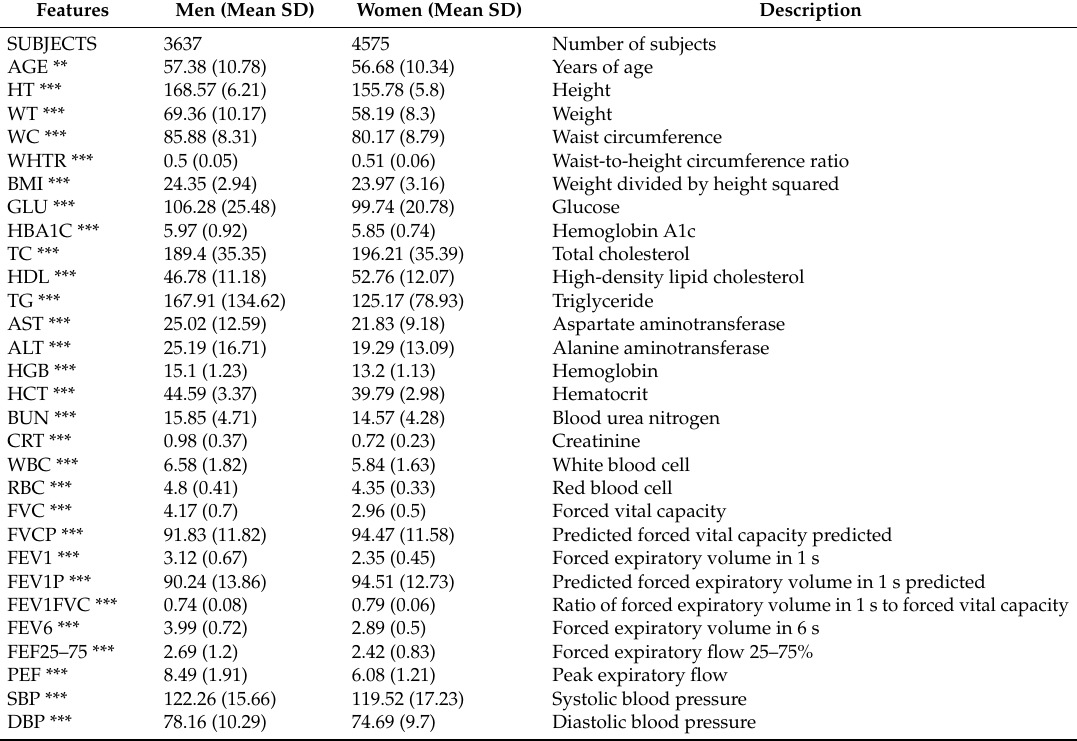
Table 1. Basic characteristics of the subjects included in this